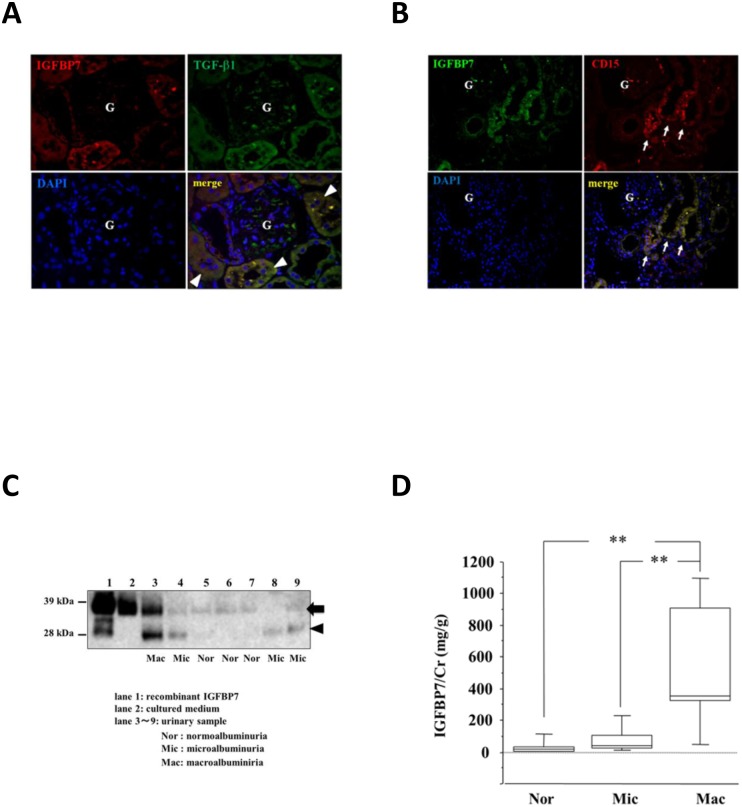
IGFBP7 in human diabetic nephropathy.(A) Colocalization of IGFBP7 and TGF-β1 in human renal tubular cells in renal biopsy form type 2 diabetic patients with overt nephropathy. IGFBP7 was localized to the cytoplasm of tubular cells but not that of glomerular cells (G) in diabetic kidney. The confocal microscopy analysis showed the presence of IGFBP7 and TGF-β1 in the proximal tubular cells as indicated by the merged images. The arrowheads indicate the partial colocalization of IGFBP7 and TGF-β1 in proximal tubules. (B) IGFBP7 expression in proximal tubular cells. Positive staining for CD-15 indicated the segment of proximal tubules. The proximal tubular cells which are characterized by a brush border and stained by CD15 showed the positive immunostaining for IGFBP7. The arrows indicate the IGFBP7-positive cells observed in CD-15 positive proximal tubules. (C) Western blot analysis of IGFBP7 immunoreactive forms in urine from patients with DN or without DN. Urine (10 μl) was processed by SDS-PAGE (10% gels) under reducing conditions and electroblotted onto PDF membranes. Lane 1, recombinant human IGFBP7 (200 ng/lane); lane 2, culture medium (10 μl); lane 3, urine sample from a patient with macroalbuminuria (Mac); lanes 5–7, individual urine samples from patients with normoalbuminuria (Nor); lanes 4, 8 and 9, individual urine samples with microalbuminuria (Mic). Arrow: 33 kDa IGFBP7, arrowhead: 25 kDa cleaved IGFBP7. (D) Increased urinary IGFBP7 levels in diabetic nephropathy. The urinary IGFBP7 levels for patients grouped according to different stages of nephropathy as having normoalbunuria (Nor), microalbuminura (Mic), or macroalbuminuria (Mac). Horizontal bars = medians, columns = interquartile ranges, and vertical bars = 95% CIs. *p<0.05, **p<0.01 by one-way ANOVA with a Tukey’s test.